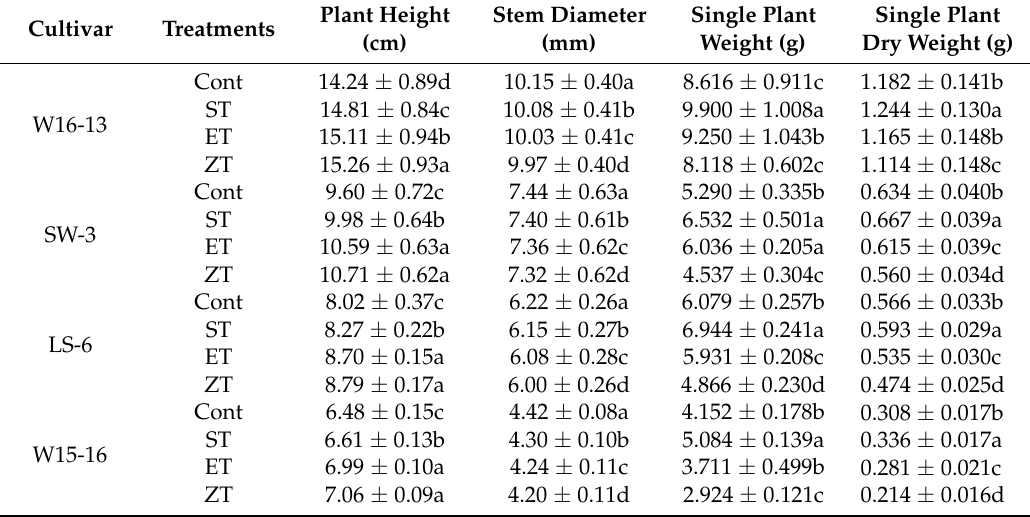
Table 4. Effects of cold stress on plant morphology in four genotypes.